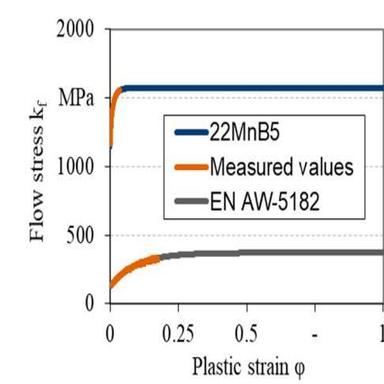
Flow curves of the examined sheet materials.